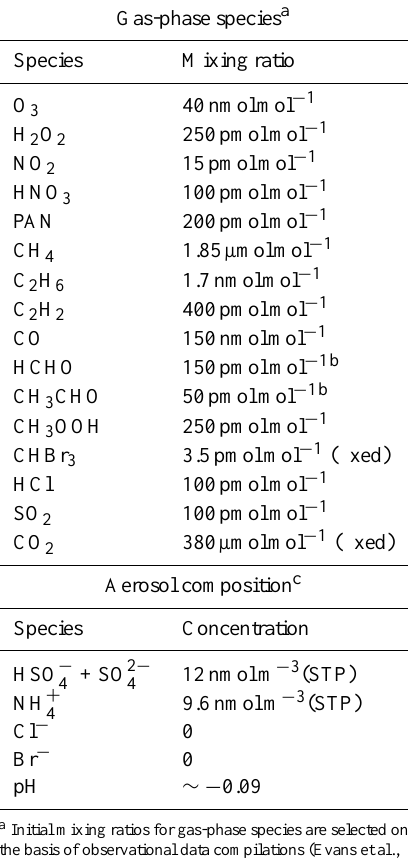
Table 4. Initial and upper boundary conditions for key trace gases (in both the atmosphere and the SIA) and aerosol composition.